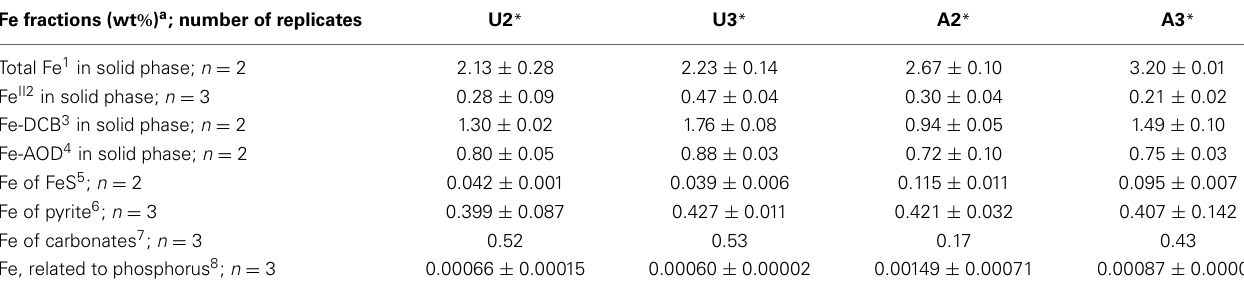
Table 2 | Iron (Fe) fractionation of unamended and amended MFT after 213 days incubation. Fe fractions (wt % ) a ; number of replicates